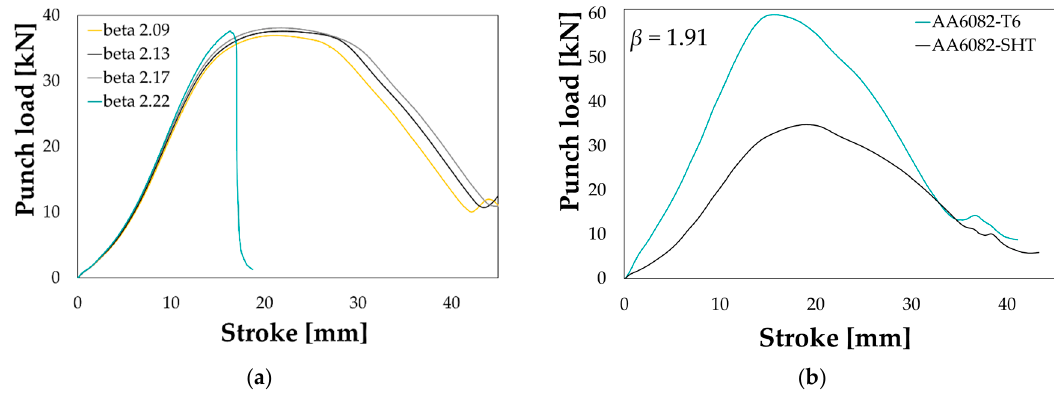
Figure 17. Punch load-stroke curve: effect of ( a ) the initial blank diameter (SHT condition, BHp = 1%) and ( b ) the initial material condition ( β = 1.91, BHp = 1.5%).